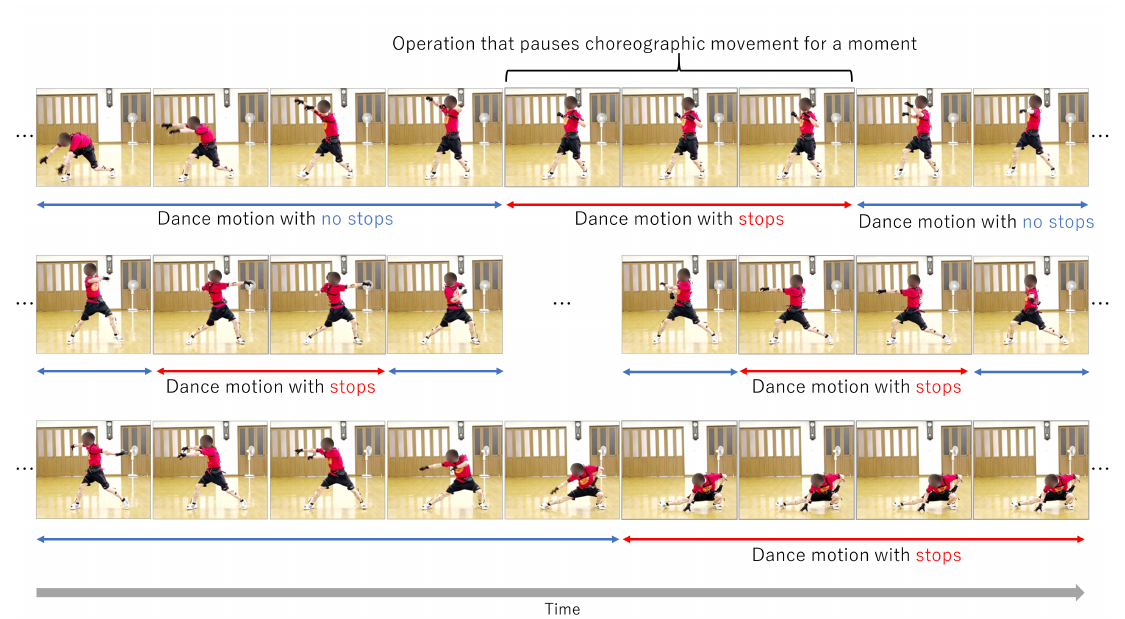
Figure 1. Demonstration of flow of motion in Yosakoi Soran dance. From left to right in the first line: no stop, stops, no stop. The stops factor is incorporated into the continuous dance process as a